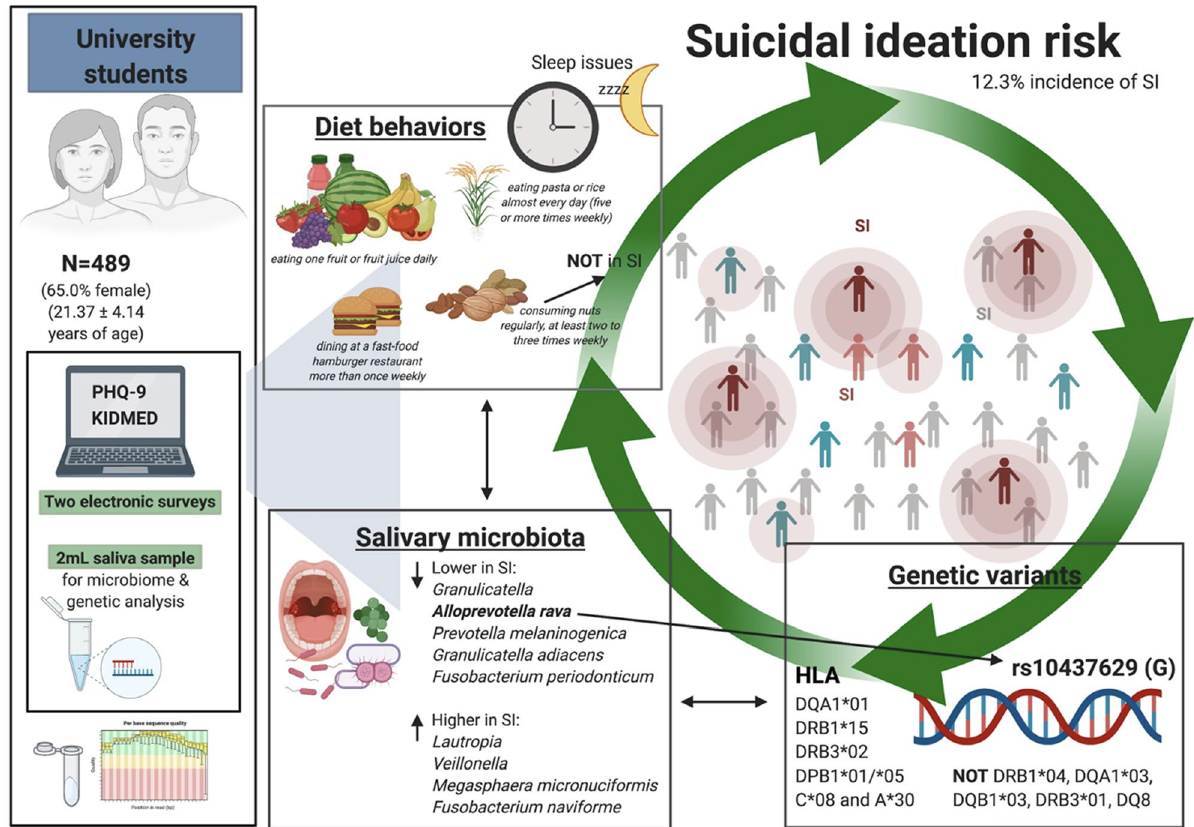
Figure 5. Summary of findings. Here we describe novel associations of diet, genetics, and the saliva microbiome with suicidal ideation (SI) in a cross-sectional study of 489 university students (65.0% female). A 12.3% incidence of SI was observed in this cohort. Students provided a 2-mL saliva sample for microbiome and genetic analysis and completed two brief surveys electronically. Dietary patterns were assessed using the KIDMED survey and SI determined by dichotomized responses to Question 9 of the Patient Health Questionnaire-9 (PHQ-9). Created with